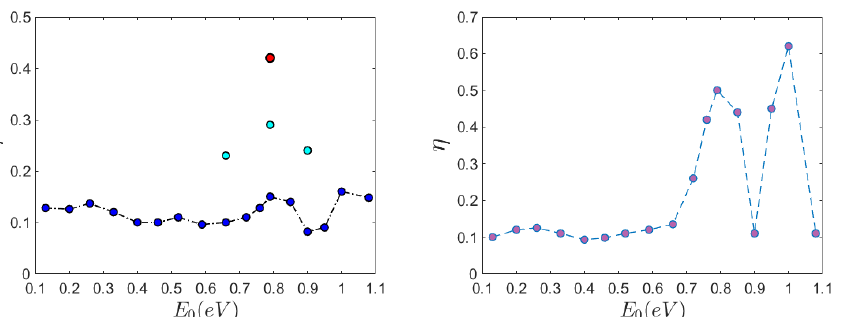
Figure 9. The normalized spectral entropy η versus the initial energy E 0 for a DNA protein. The parameters are the same as those reported for Figure 1. The left panel refers to N = 398 bp where the dark blue circles correspond to the initial electron excitation peaking around the site n 0 = N /2, the light blue circles correspond to n 0 = N /3, and the red circle correspond to n 0 = 2 N /3. The right panel refers to N = 66 bp and the initial electron excitation peaks around the site n 0 = N /2. In panel (b) η versus E 0 is reported for the shorter DNA segment and